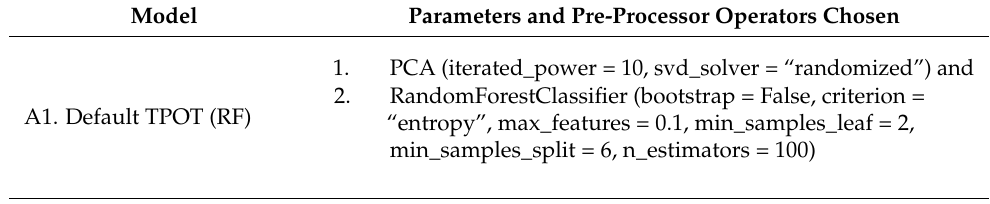
Table 5. Parameters and pre-processor operators of each